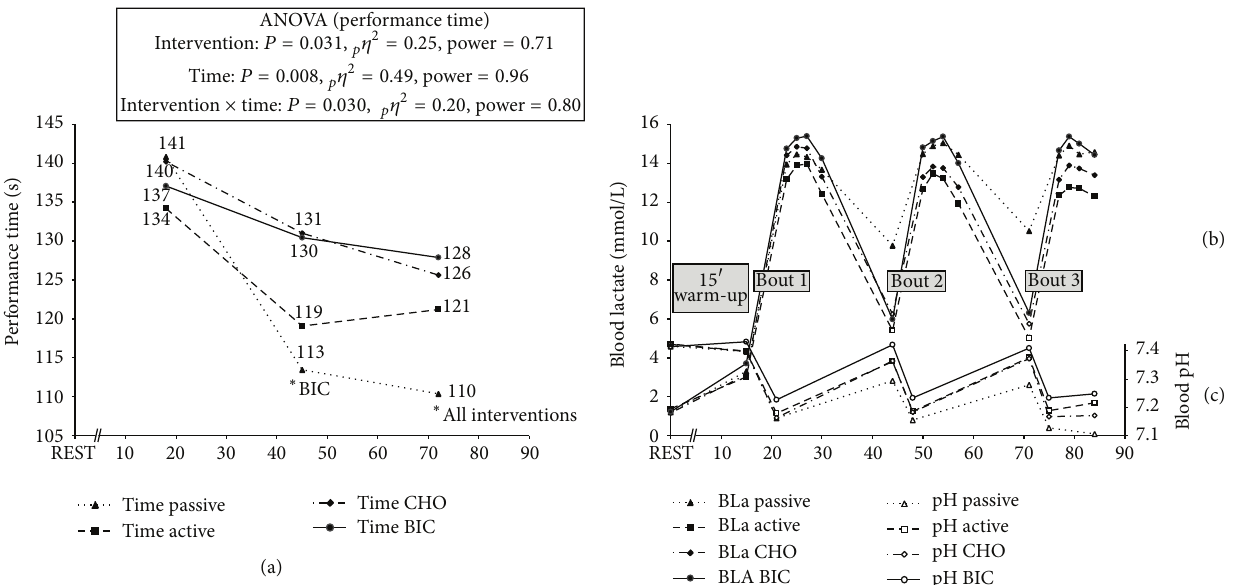
Figure 2: Development of running performance (a), blood lactate (b), and pH (c) across the entire experiment including resting values, post- warm-up values, and postbout values. PASSIVE: passive recovery with placebo; ACTIVE: active recovery with placebo; CHO: active recovery with carbohydrate ingestion; BIC: active recovery with sodium bicarbonate ingestion. ∗ Significant difference to specified